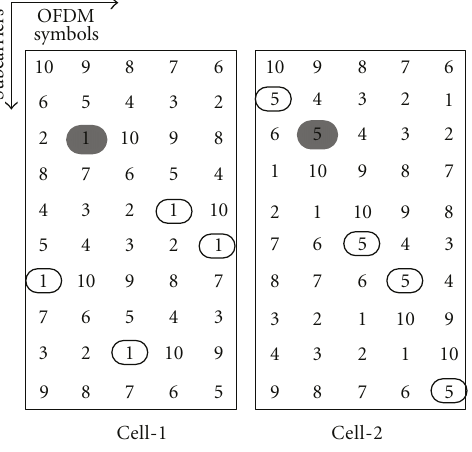
Figure 4: Two di ff erent FH patterns are given and their only collision point is